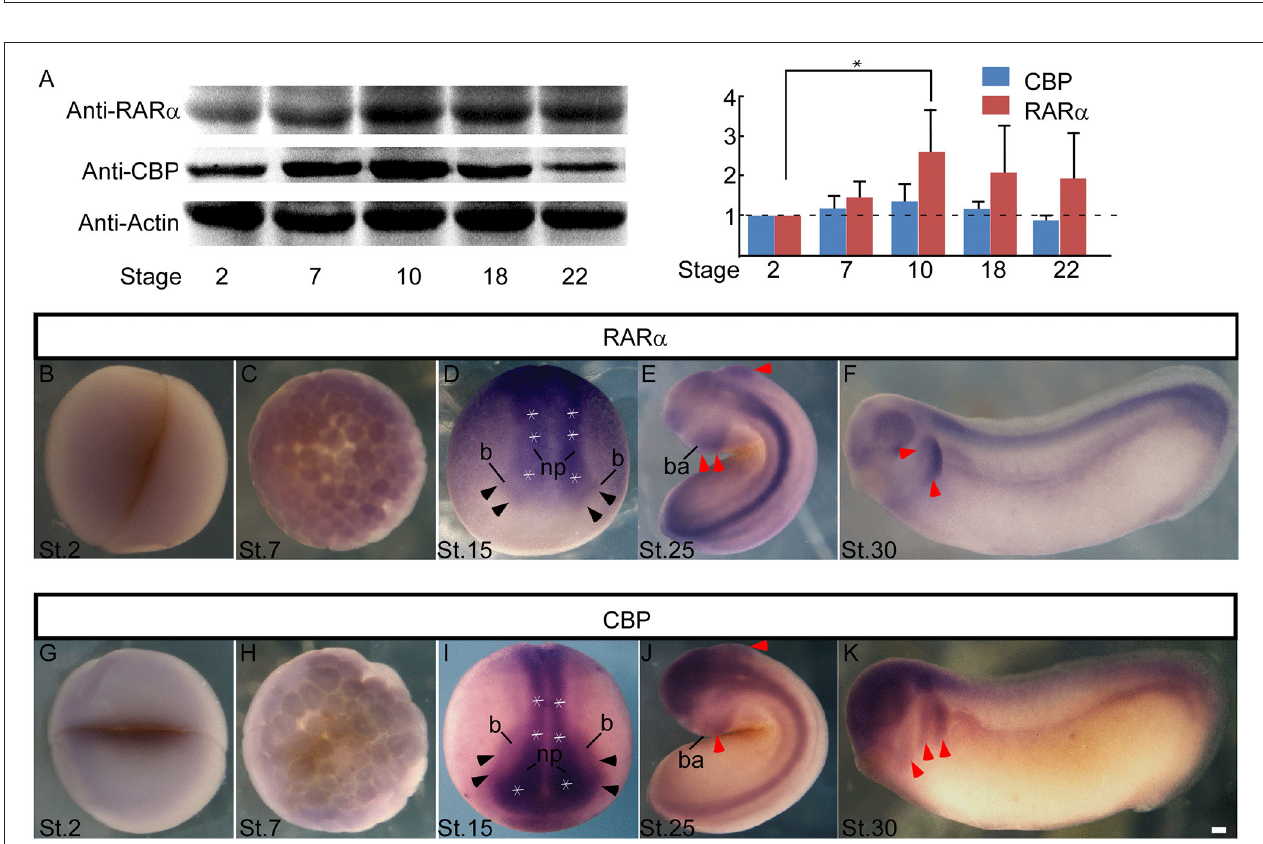
FIGURE 1 | colocalization (H) with NeuN (red) (E) . (I–L) In aganglionic segments, NeuN (I) and CBP (J) are absent within the neural plexus, and CBP is expressed faintly in the muscularis propria of the colon, as shown in the merged panel (L) . (M–P) In normal ganglionic segments, RAR α (M) colocalizes with β -tubulin III (N) , as shown in the merged panel (P) . (Q–T) RAR α (Q) is absent and β -tubulin III (R) is weakly expressed in aganglionic segments. (U–X) In normal ganglionic segments, RAR α (U) labels nerve fibers and CBP (V) indicates ganglion cells. (X) Both proteins display partially overlapping patterns within the neural plexus. (Y) RAR α (0.459 ± 0.273) and CBP (0.569 ± 0.196) transcripts were significantly lower in aganglionic segments than in normal regions. NS, normal ganglionic segments; AS, aganglionic segments. Numbers in brackets indicate the relative expression ratio of pathogenic aganglionic segments to normal ganglionic segments. Dashed lines encircle the